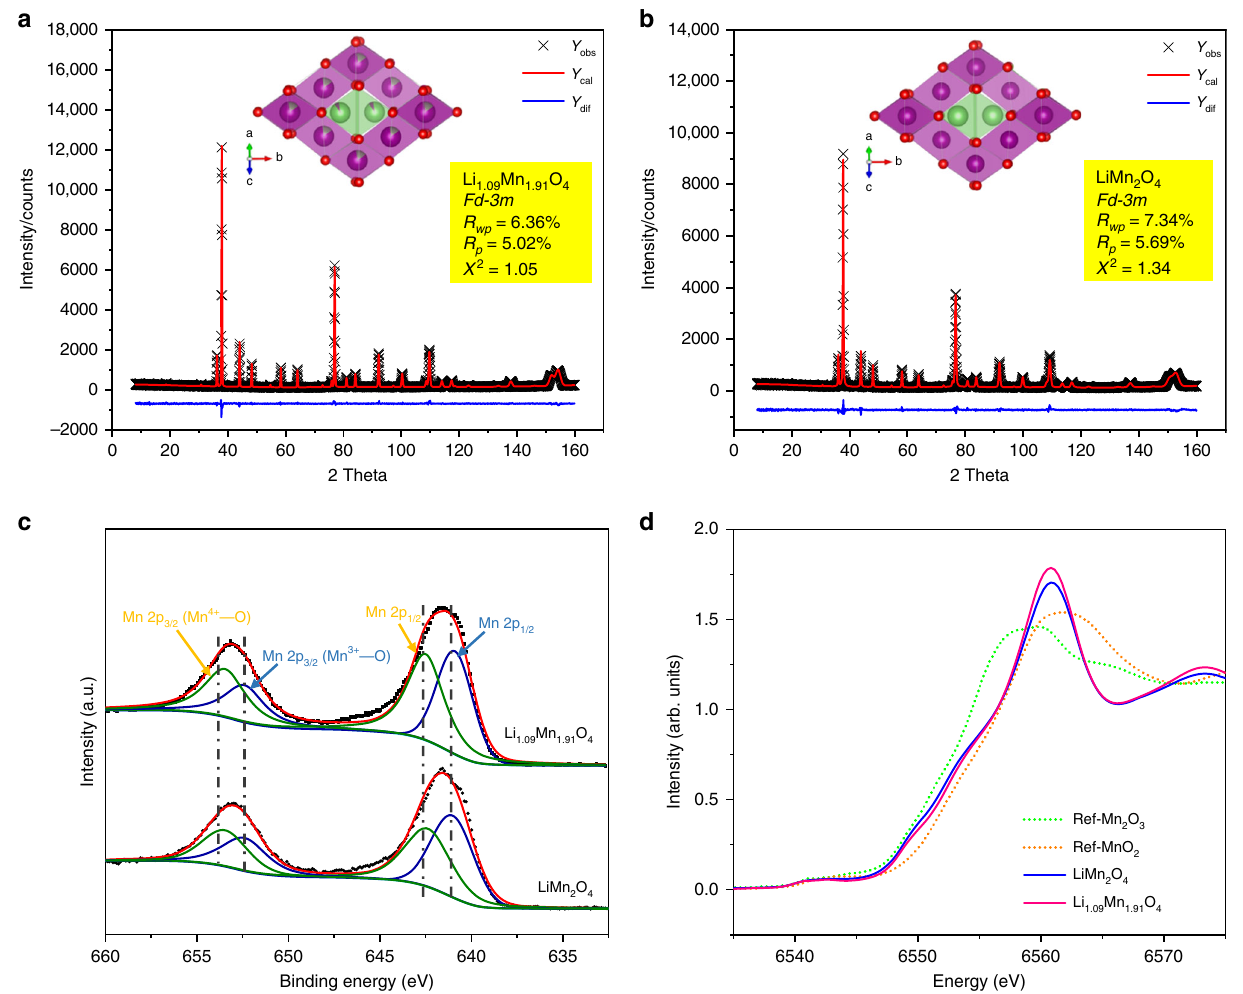
Fig. 6 Accurate quantitative atomic occupancy analysis via neutron diffraction and the oxidation state analysis of Mn. a , b The neutron diffraction and Retvield re fi nement of LR-LMO and LMO powders. The inserted structure diagrams of LR-LMO and LMO. The green, purple, and red atoms represent Li, Mn, and O, respectively. c Mn 2p 1/2 and 2p 3/2 spectra and fi tting results of LR-LMO and LMO samples. d Mn K edge XANES and fi tting results of LR-LMO and LMO